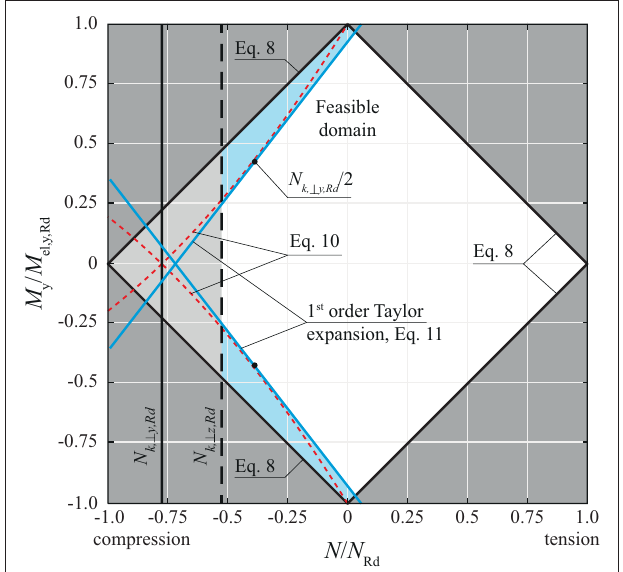
FIGURE 2 | Example of the feasible domain for normal force and bending moment interaction for an HEA 160 section assigned at a column of 3.50m length.